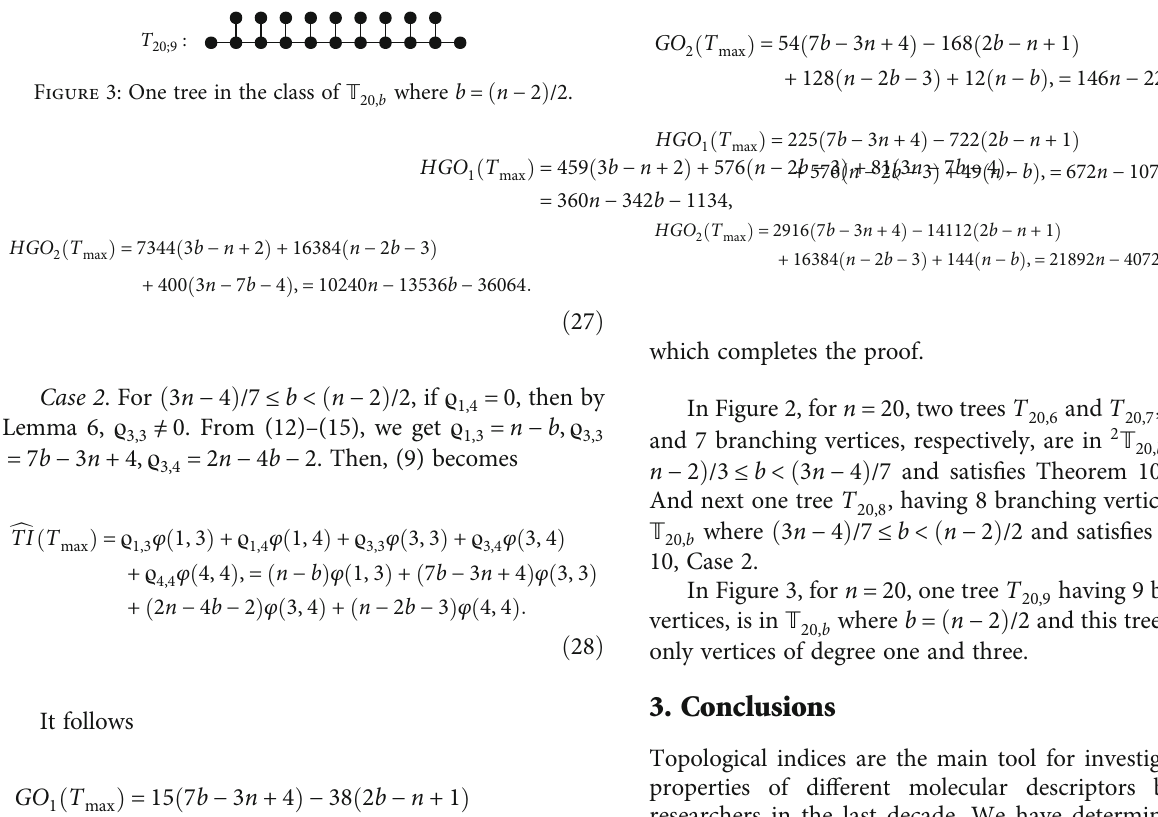
n − 2 Þ /3 ≤ b < ð n − 2 Þ /2 . 20, b where ð